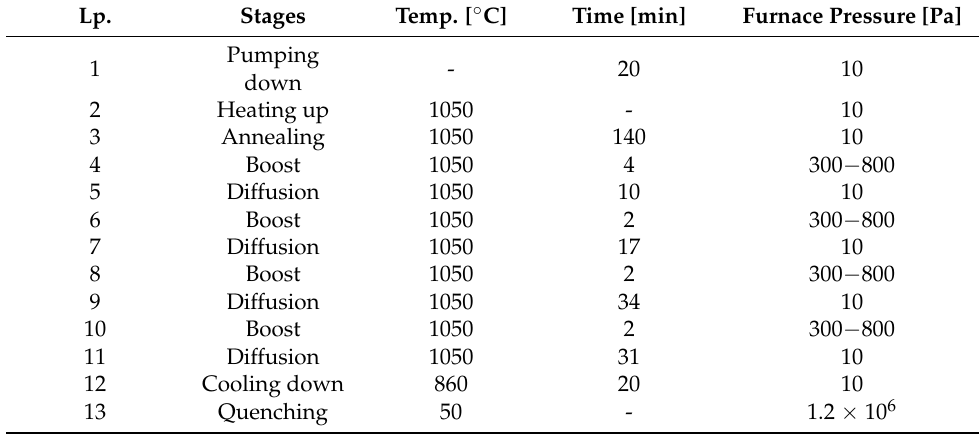
Table 3. Parameters of annealing and carburizing